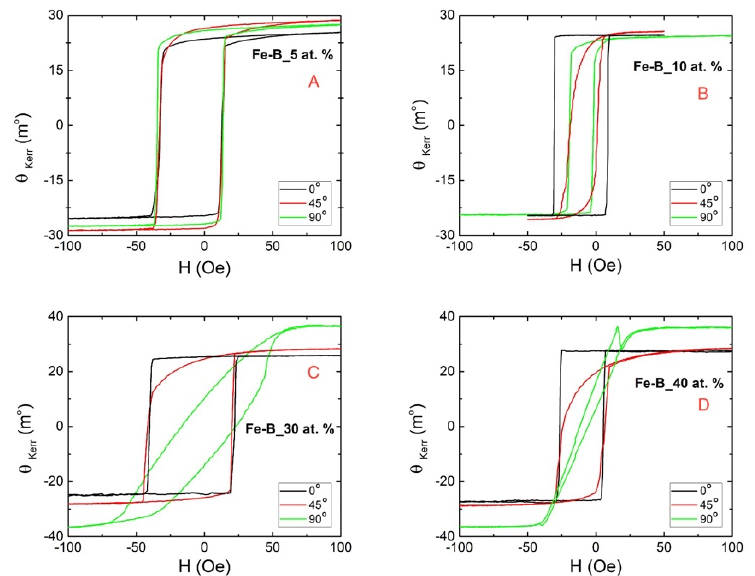
Figure 9. MOKE hysteresis loops for Fe-B films obtained by TVA. Different orientations of the magnetic field with respect to a reference in plane direction are considered. ( A ) is Fe-B 5 at. %, ( B ) is Fe-B 10 at. %, ( C ) is Fe-B 30 at. %, and ( D ) is Fe-B 40at. %.